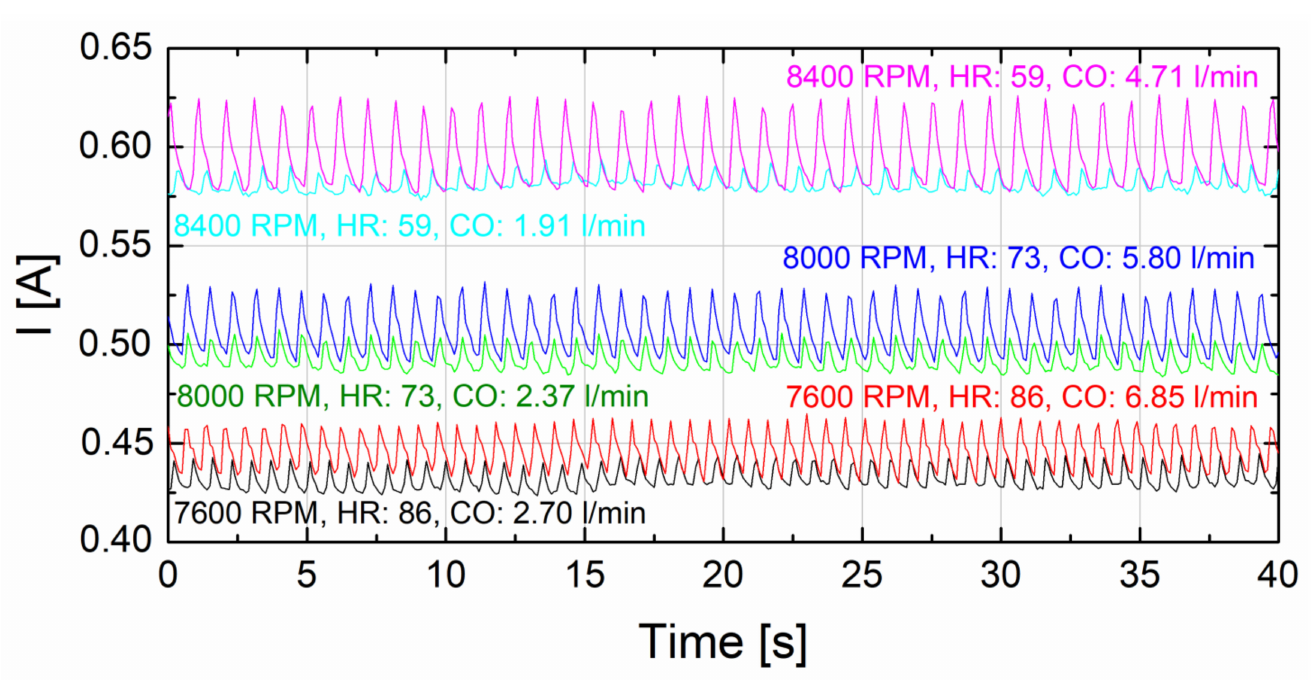
Figure 3. Time chart of the Sputnik LVAD electric current at similar HRs and speed levels for the two different CO levels corresponding to the simulated states of initial LVAD support and significant myocardial recovery. LVAD speed levels (black and red curves for 7600 rpm; green and blue curves for 8000 rpm; turquoise and magenta curves for 8400 rpm) are the minimum, mean, and maximum speed values in the investigated